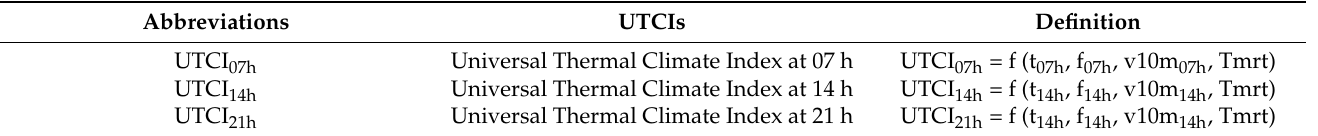
Table 2. Definition of UTCIs used in the